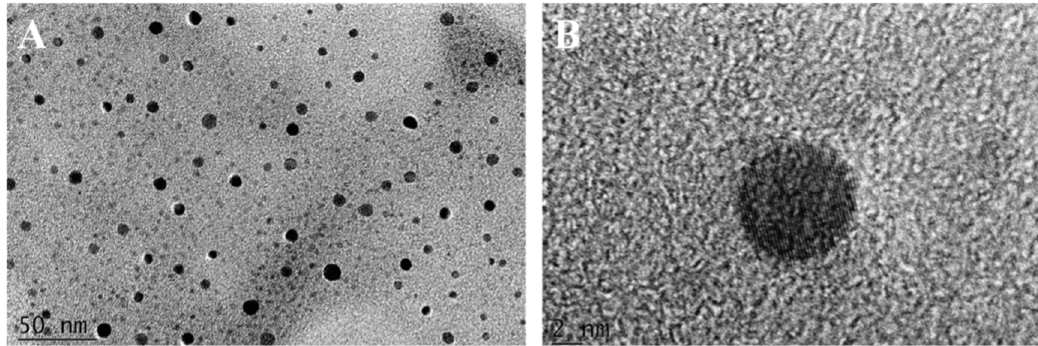
Figure 2. TEM ( A ) and HRTEM images ( B ) of R ‐ CDs.